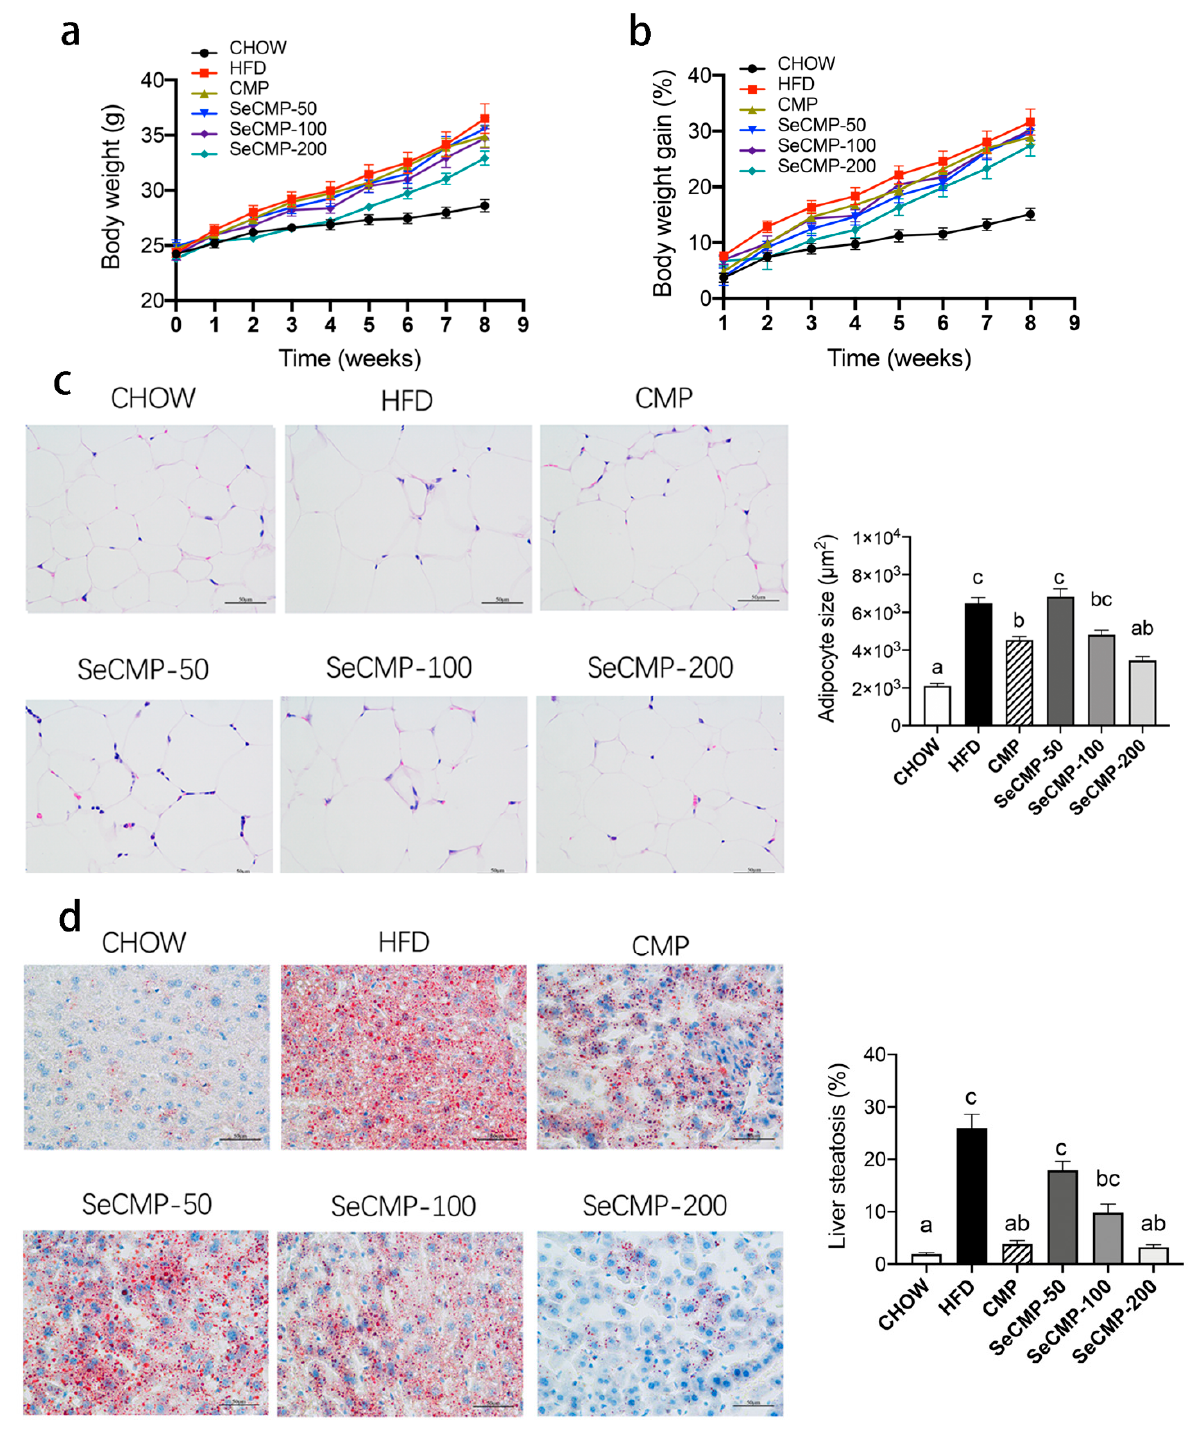
Figure 1. The effect of selenium-rich C. militaris crude polysaccharides (SeCMP) and selenium-deficient C. militaris crude polysaccharides (CMP) on body weight and alleviated lipid accumulation in high-fat diet-induced obese C57BL/6J mice. ( a ) The body weight, ( b ) body weight gain throughout the experiment, ( c ) mean adipocyte size, and ( d ) liver steatosis ratio stained with oil-red O dye. Scale bars: 50 μ m. Data are expressed as mean ± SE (n = 8 mice/group). Superscript characters indicate significant variation among treatments. CHOW: normal diet + sterile water; HFD: high-fat diet + sterile water; CMP: high-fat diet +100 mg/kg CMP; SeCMP-50: high-fat diet +50 mg/kg SeCMP; SeCMP-100: high-fat diet +100 mg/kg SeCMP; SeCMP-200: high-fat diet +200 mg/kg SeCMP.